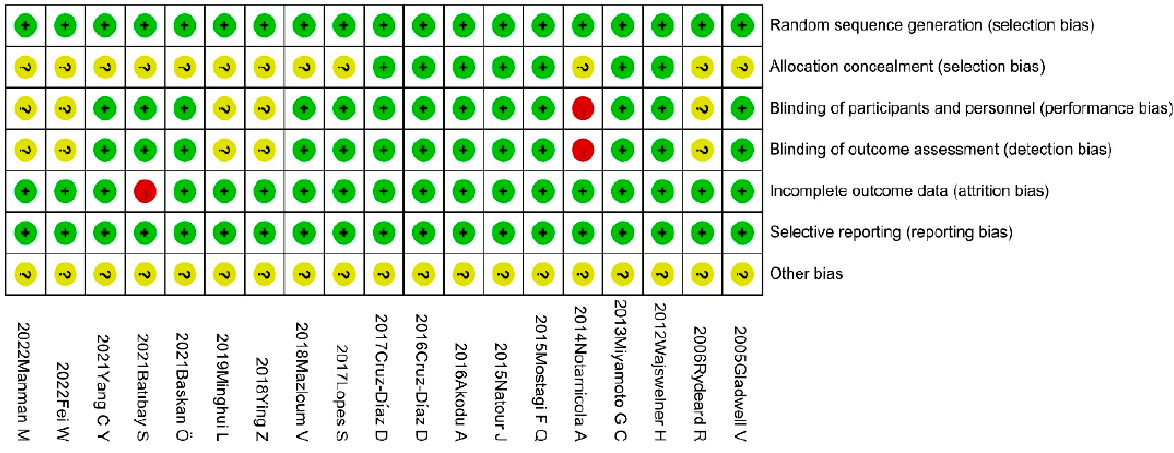
Figure 3. Punctuation of risk of bias tool [12,18–23,36,45–55].